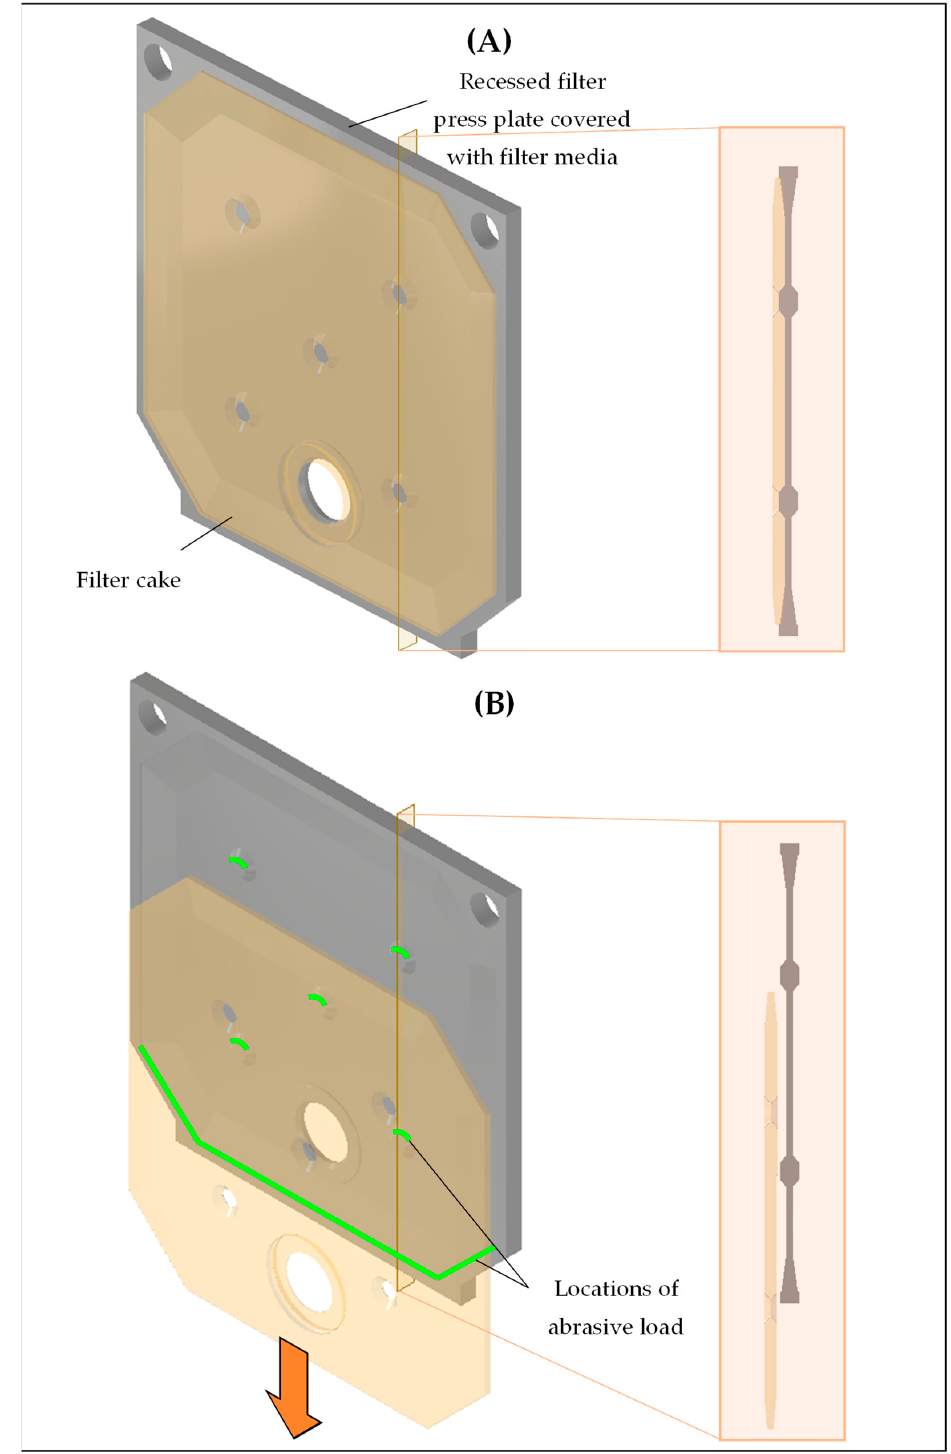
Figure 1. Schematic representation of the locations of abrasive load on the filter media due to protruding parts of the filter plate. ( A ) Filter cake adhering to filter cloth. ( B ) Falling filter cake. In general, suppliers give a rough wear classification of their filter media based on the materials used. Explicit information in relation to the application they are used for on individual fabrics is usually not